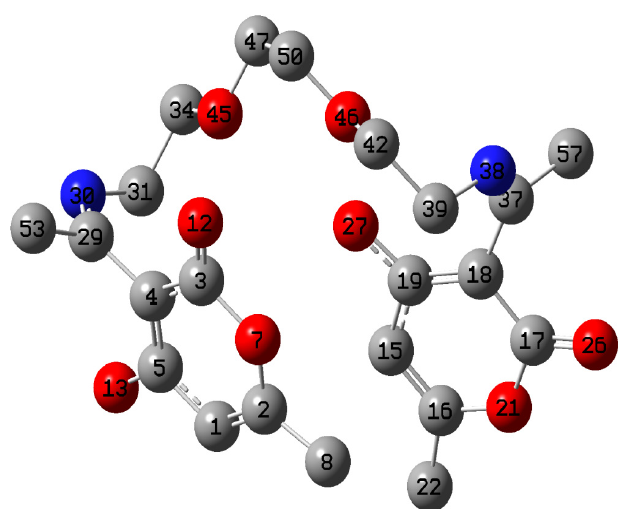
Figure 8. Optimized structure of SB showing only non-hydrogen atoms with atomic